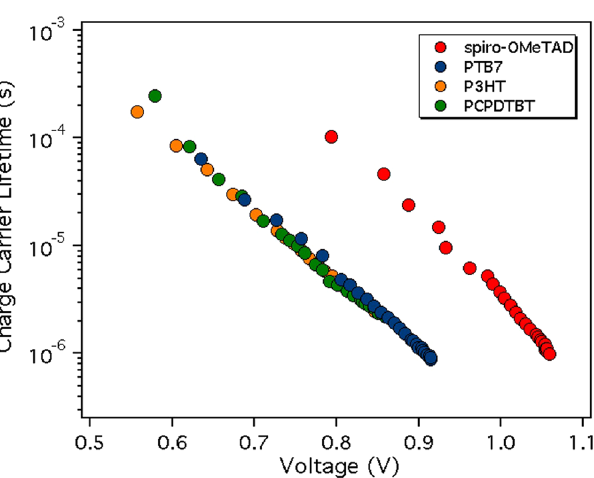
Figure 7. The different τ measured using PI-TPV vs light bias (photoinduced voltage).